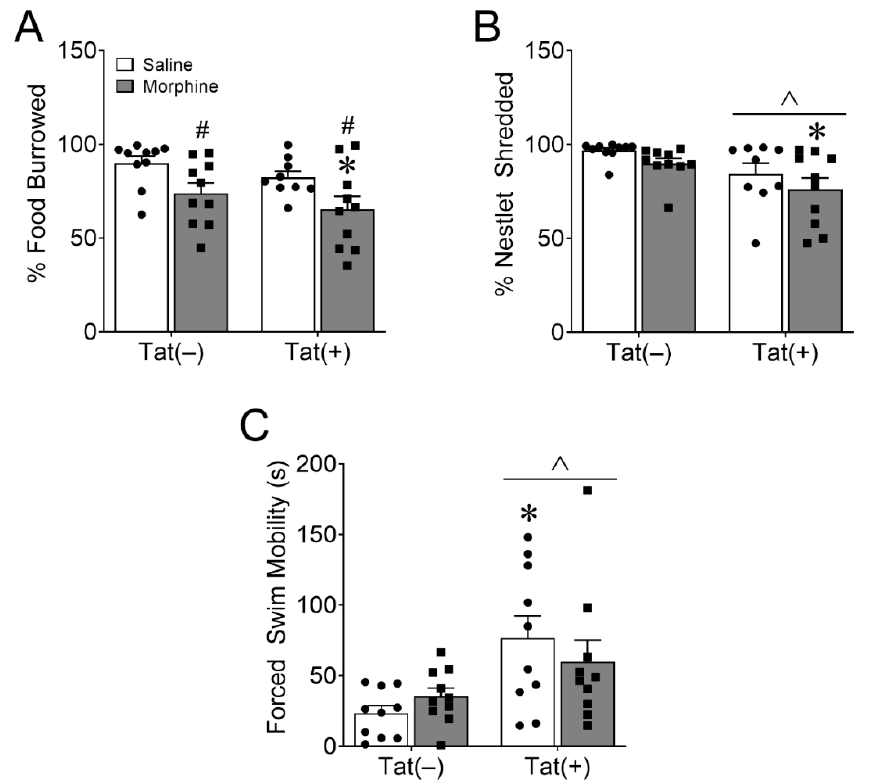
Figure 3. Morphine decreased burrowing, whereas HIV-1 Tat decreased nestlet shredding and adaptability. The main effects indicate that escalating morphine exposure (10–40 mg/kg, increasing by 10 mg/kg/2 day, s.c., b.i.d.) decreased burrowing of food pellets ( A ), whereas Tat exposure for eight weeks decreased shredding of a pressed cotton nestlet ( B ). However, planned comparisons indicate that Tat(+) and morphine co-exposure increased burrowing ( A ) and nestlet shredding ( B ) significantly more than Tat(–) and saline-treated mice, suggesting that Tat(+) and morphine co-exposure are driving the main effects. Tat exposure also increased overall mobility in the forced swim test. Planned comparisons indicate that saline-treated Tat(+) mice were significantly more mobile than saline-exposed Tat(–) mice ( C ). Data are presented as the mean ± the SEM; n = 9–10 mice per group; * p < 0.05 interaction vs. Tat(–) Saline; ^ p < 0.05 main effect of Tat; # p < 0.05 main effect of morphine.